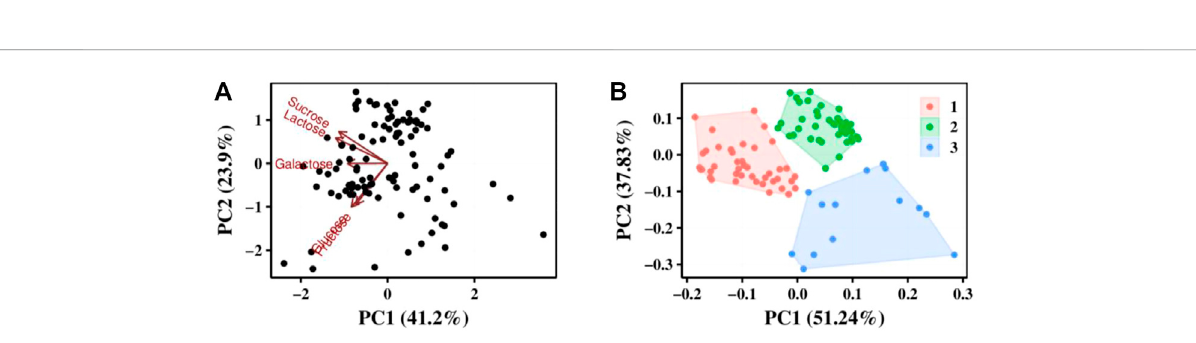
Fermentation characteristics of 100 S. thermophilus strains. (A) Correlation analysis between lactic acid production in fresh milk (fermentation time 6 h) and OD. (B) Correlation analysis between lactic acid production in UHT milk (fermentation time 5 h) and OD. (C) Classi fi cation of 100 S. thermophilus strainsaccordingtotheiracidproductioncharacteristicsinfreshmilk(fermentationtime6 h)andUHTmilk(fermentationtime5 h). (D) The viscosity and texture of 100 S. thermophilus strains in fresh milk for 8 h fermentation.